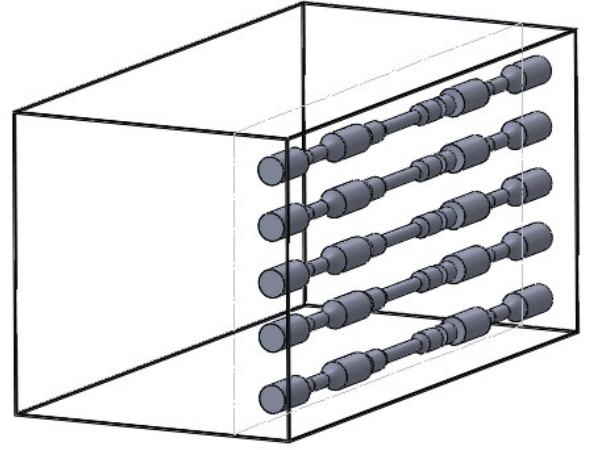
Figure 1. Isometric view of the arrangement of the specimens in the solid material